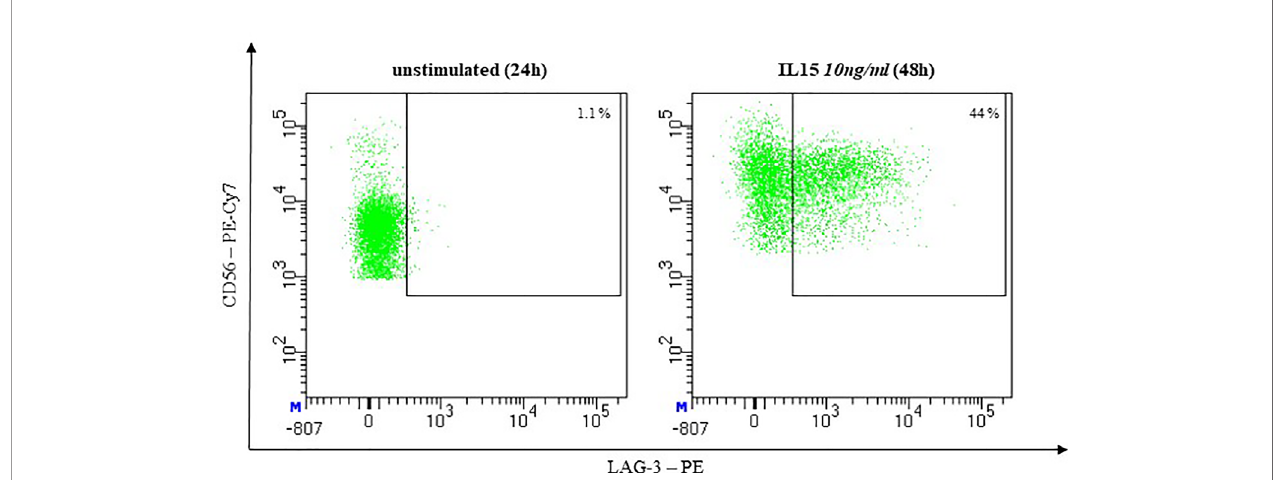
FIGURE 9 | Representative fl ow cytometric analysis of LAG-3 Expression on NK cells. Comparison of unstimulated NK cells after 48h of co-incubation with complete medium (left) and stimulated NK cells after 48h of co-incubation with 10ng/ml IL-15 (right). (healthy donor, female, 65 years